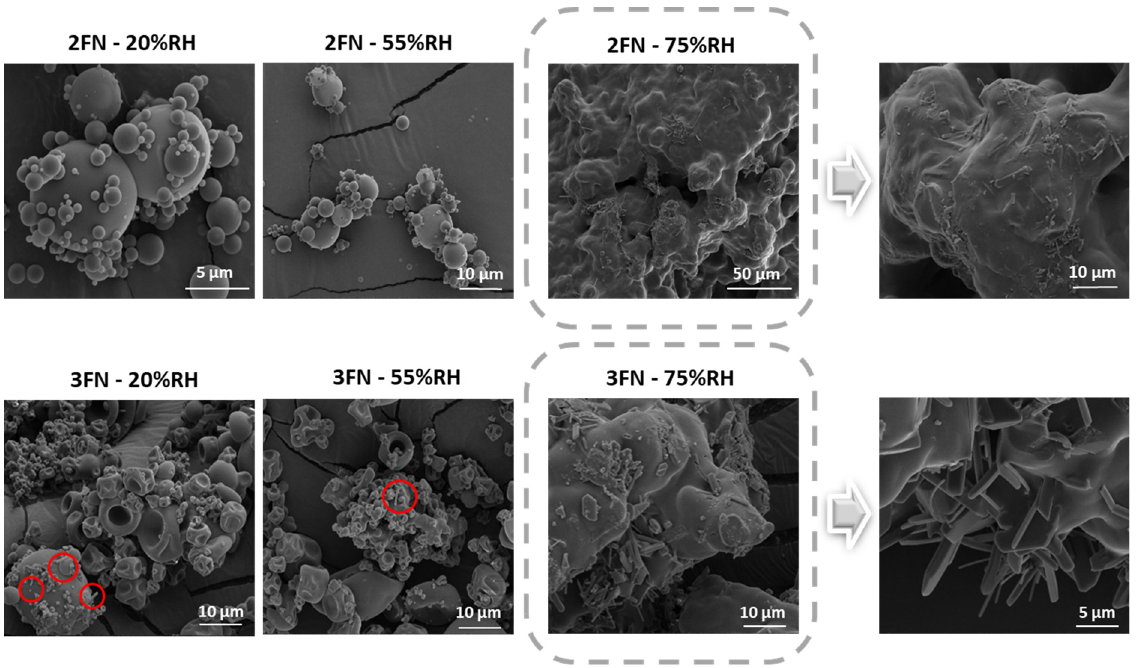
Figure 7. SEM images of naproxen-PVP dispersions (2FN and 3FN) stored under different RH after 60 days. Red circles indicate crystals.